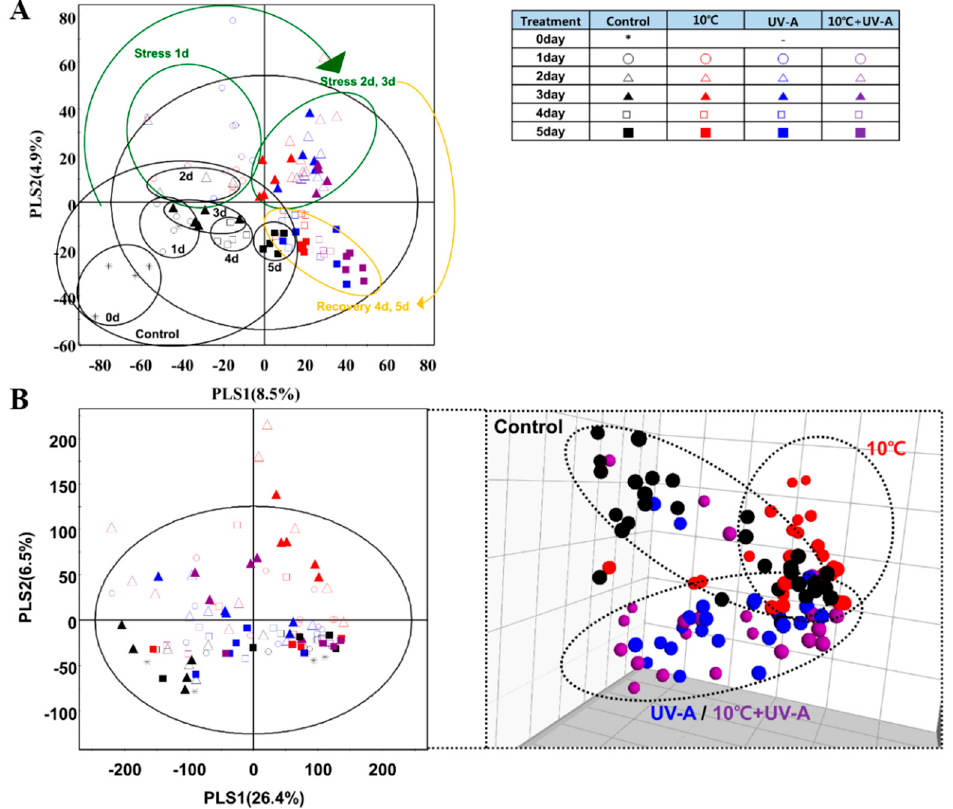
Figure 4. Partial least square–discriminant analysis (PLS–DA) score plots derived from ultra ‐ performance liquid chromatography–quadrupole–time ‐ of ‐ flight–mass spectrometry (UPLC–Q–TOF– MS) ( A ) and gas chromatography–time ‐ of ‐ flight–mass spectrometry (GC–TOF–MS) ( B ) data for